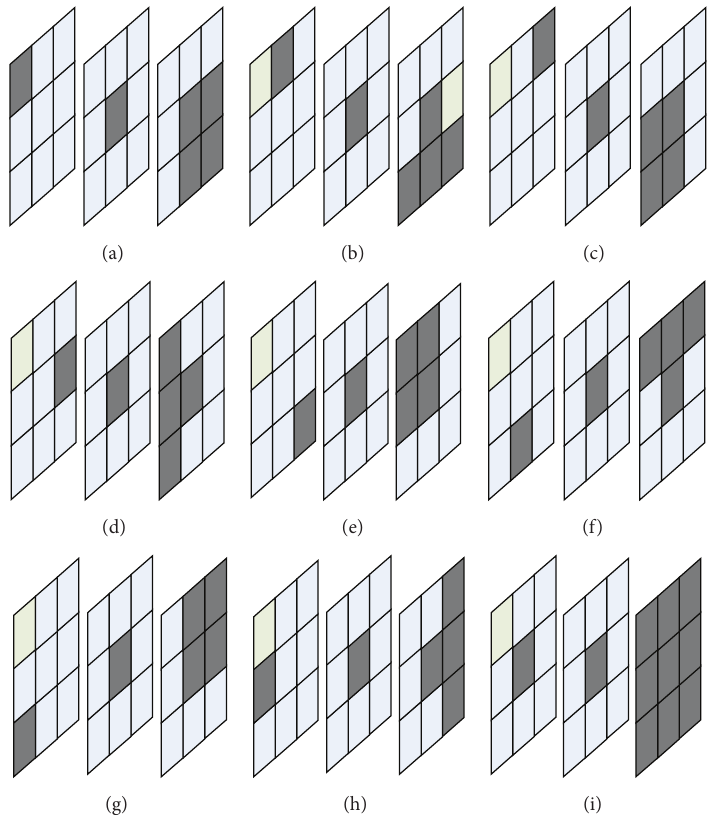
Figure 4: Possible patterns of a target moving in consecutive three frames.